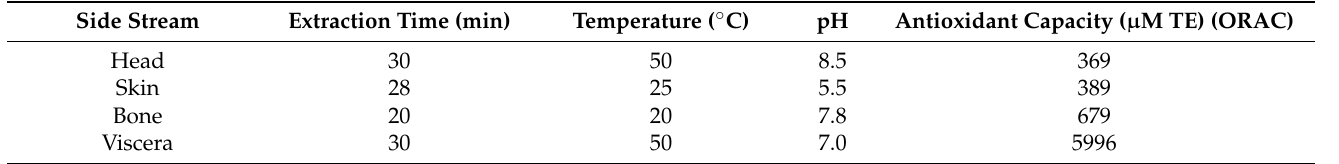
Table 8. Optimal conditions for ORAC optimal